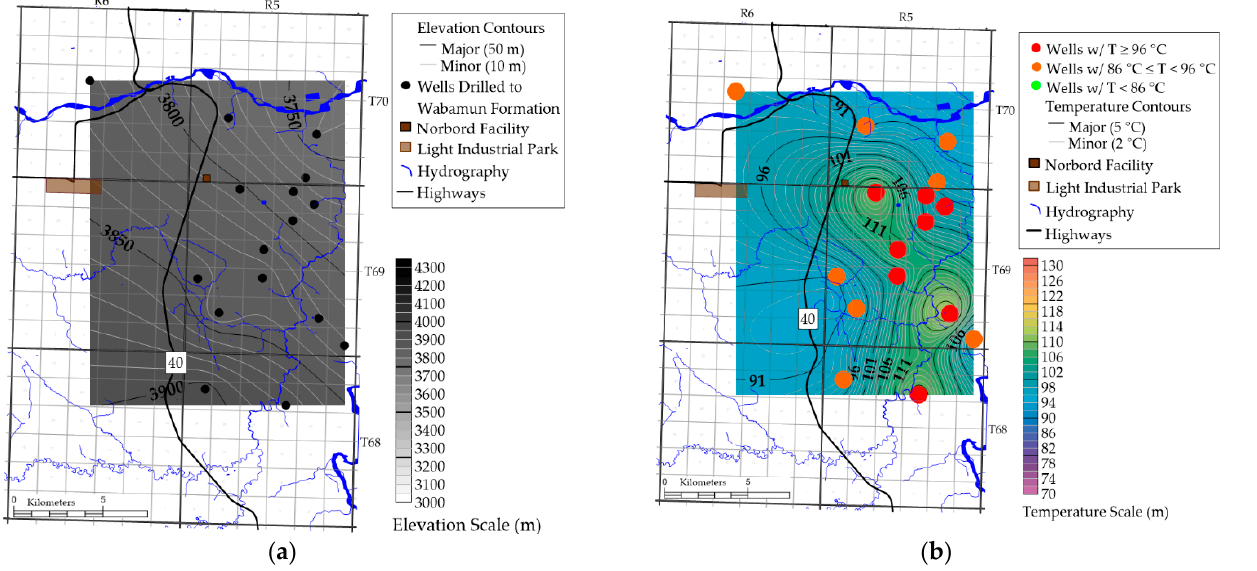
Figure 8. Contour maps of the drilling area for the Precambrian Basement showing ( a ) depth to the top and ( b ) temperature at the top.